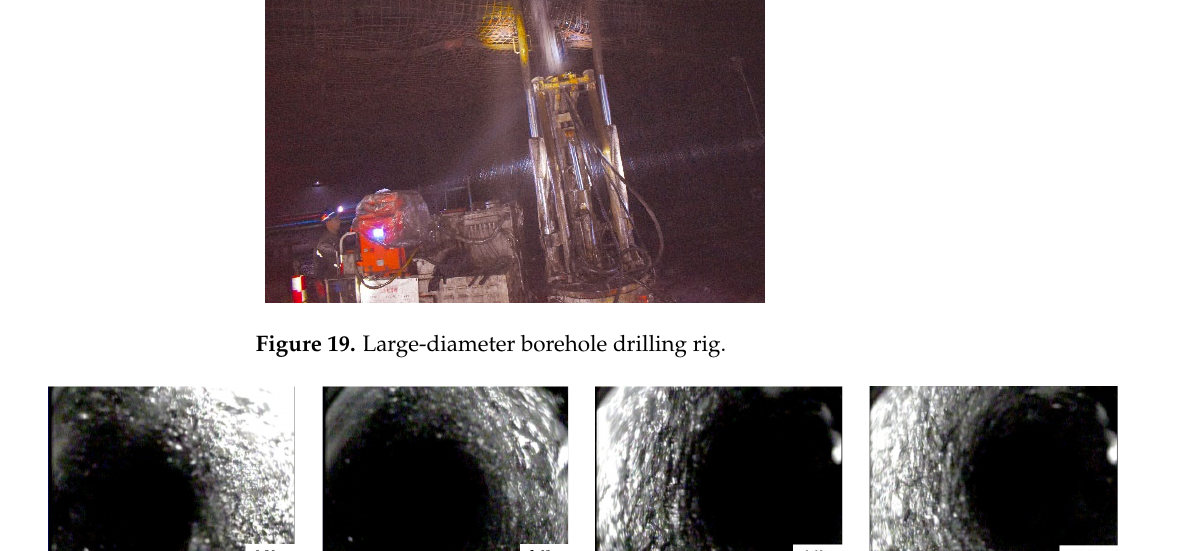
Figure 19. Large ‐ diameter borehole drilling rig.